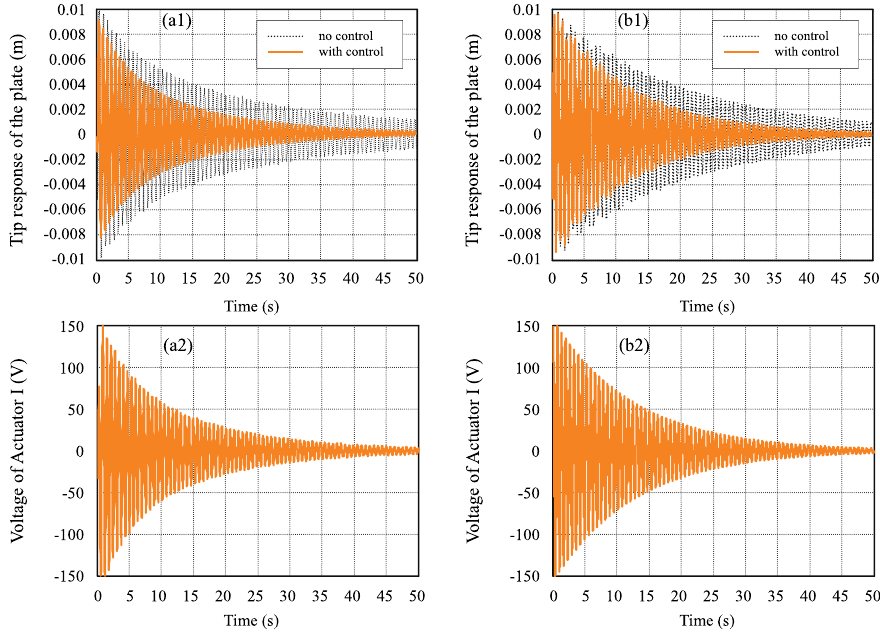
Fig. 11. Response of the plate and applied voltage of Actuator I when ¯ K = [ − 452 . 2514 , 46 . 1893] is used for the plate with time delay τ = 0 . 13s (one actuator case). (a) experimental result; (b) simulation result.